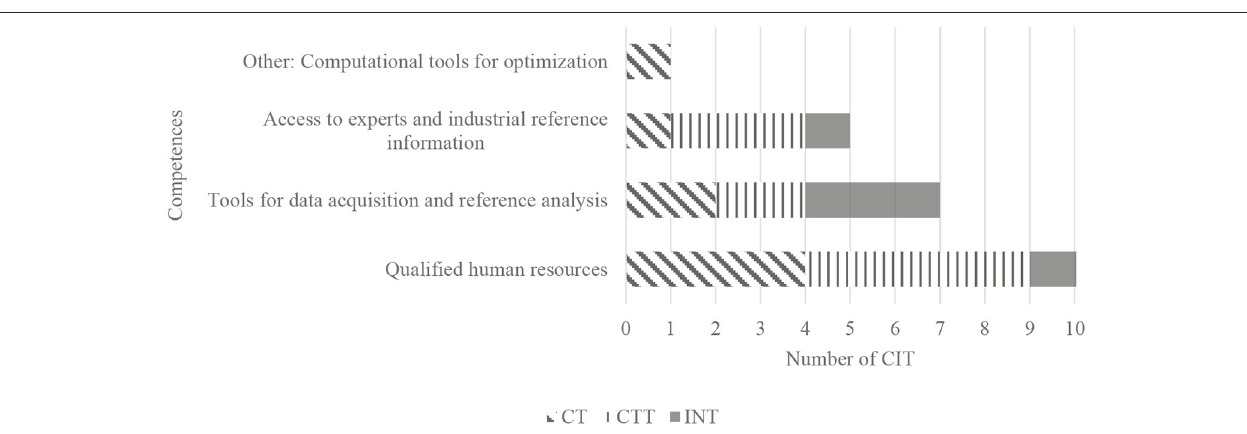
FIGURE 7 | Competences to assist companies in determining material and energy